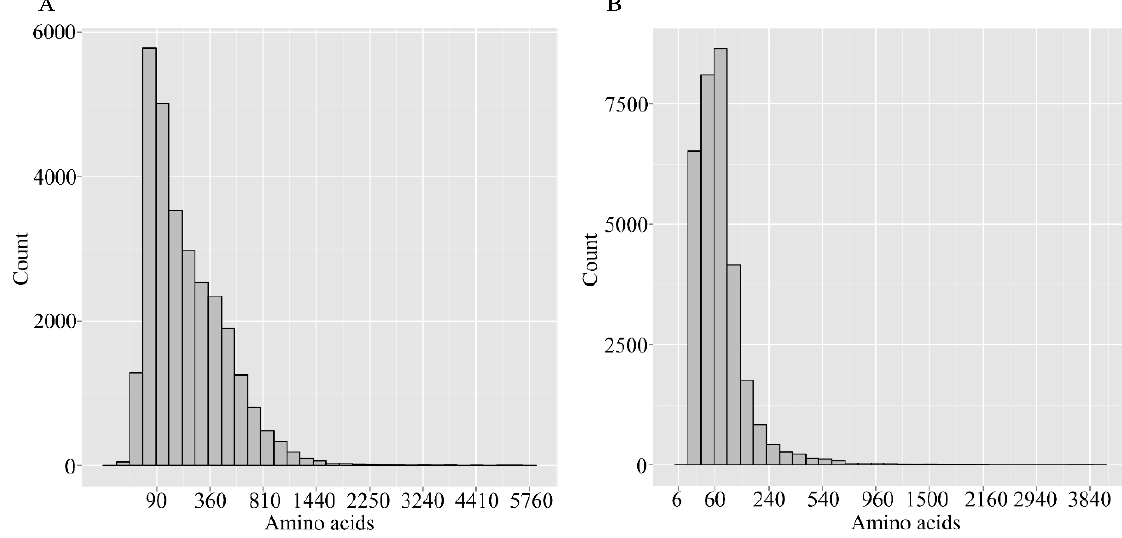
Figure 3. Length distributions of predicated peptides. ( A ) Predicated by BLAST; ( B ) Predicated by ESTScan program (Available online: http://www.ch.embnet.org/ software/ESTScan.html). The abscissa represents the peptide length, while the ordinate represents thce number of the corresponding